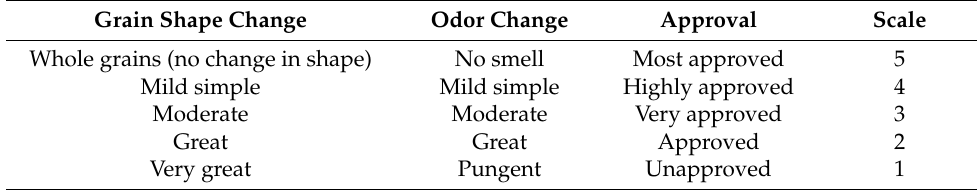
Table 1. Scale for maize grain approval based on the change in shape and